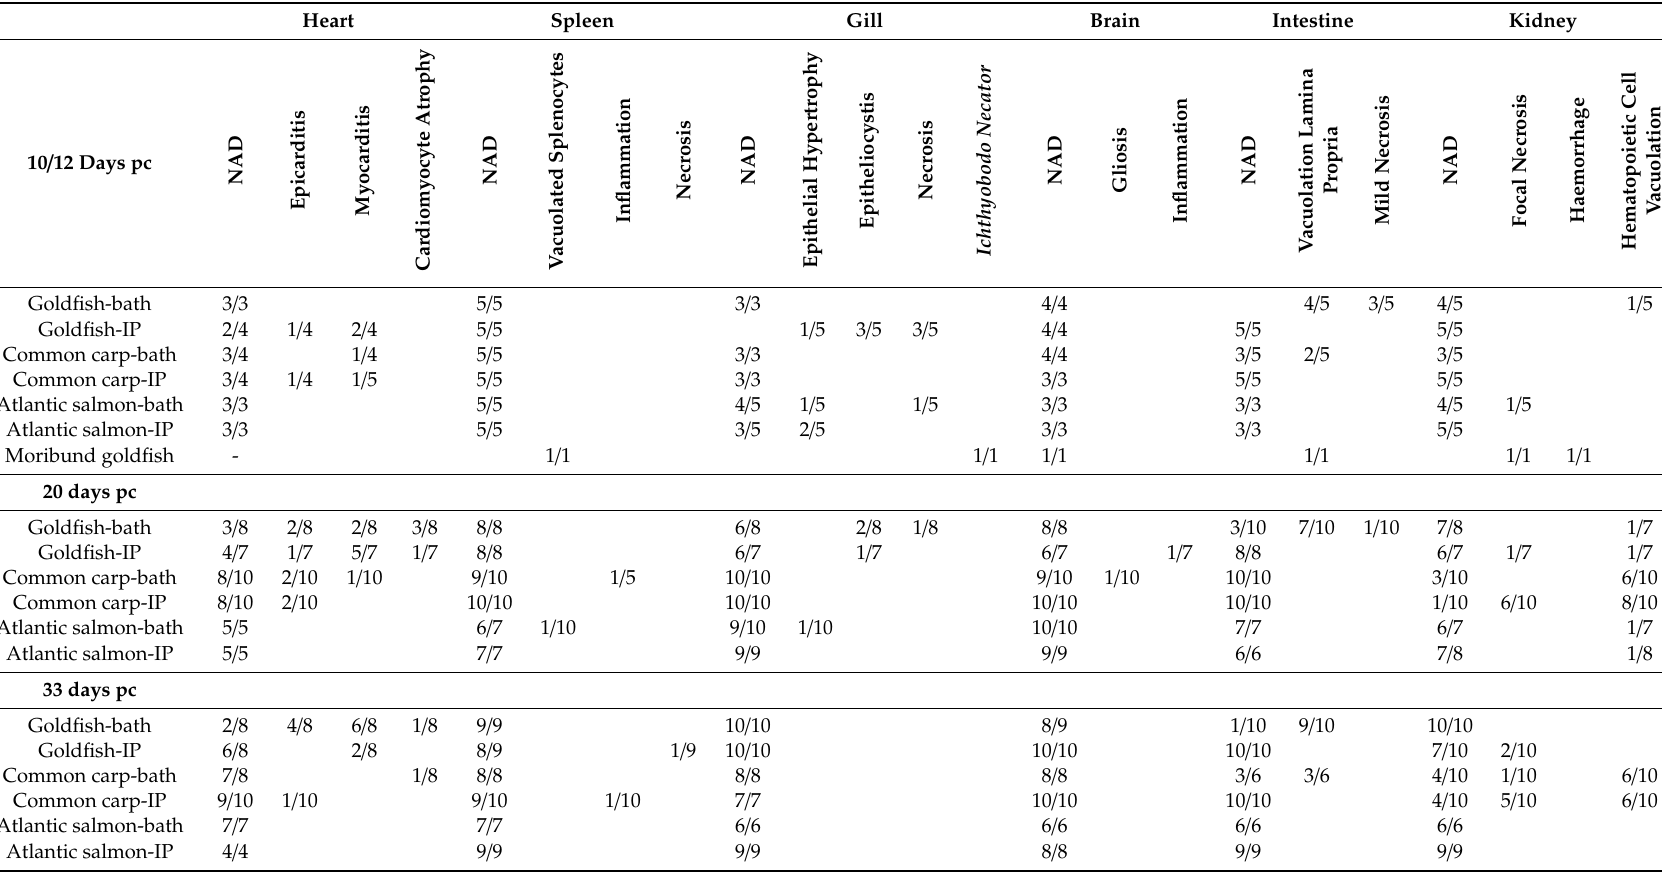
Table 4. Histopathological changes observed in intraperitoneal (IP)-injected and bath-challenged goldfish, common carp and Atlantic salmon exposed to the goldfish chinook salmon bafinivirus Cefas-W054 and sampled at 10 (goldfish and common carp), 12 (Atlantic salmon), 20 and 33 days post-challenge (pc). NAD: no abnormalities